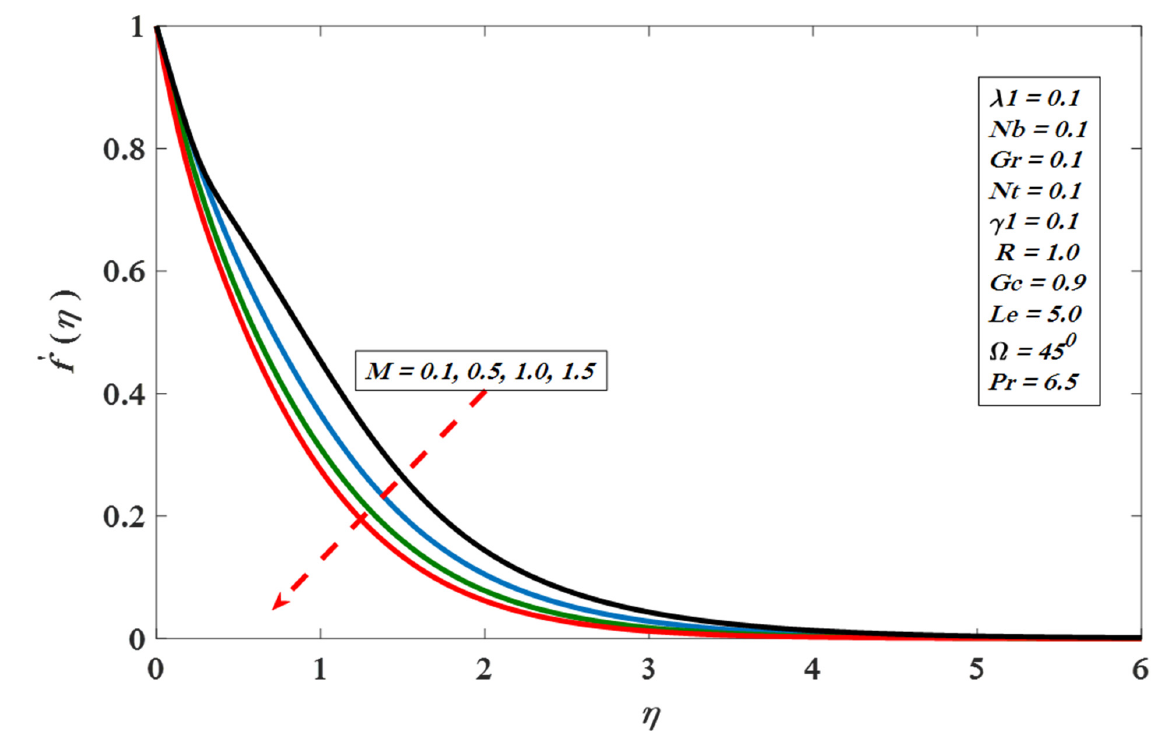
Figure 2. Velocity profile versus M .